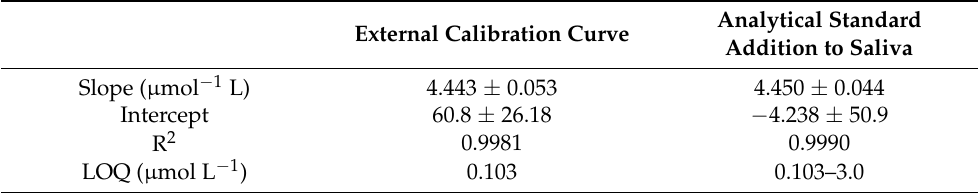
Table 1. Calibration curves and limit of quantitation LOQ for the determination of dihydrouracil DHU by HPLC-DAD ( N = 3 replicates).